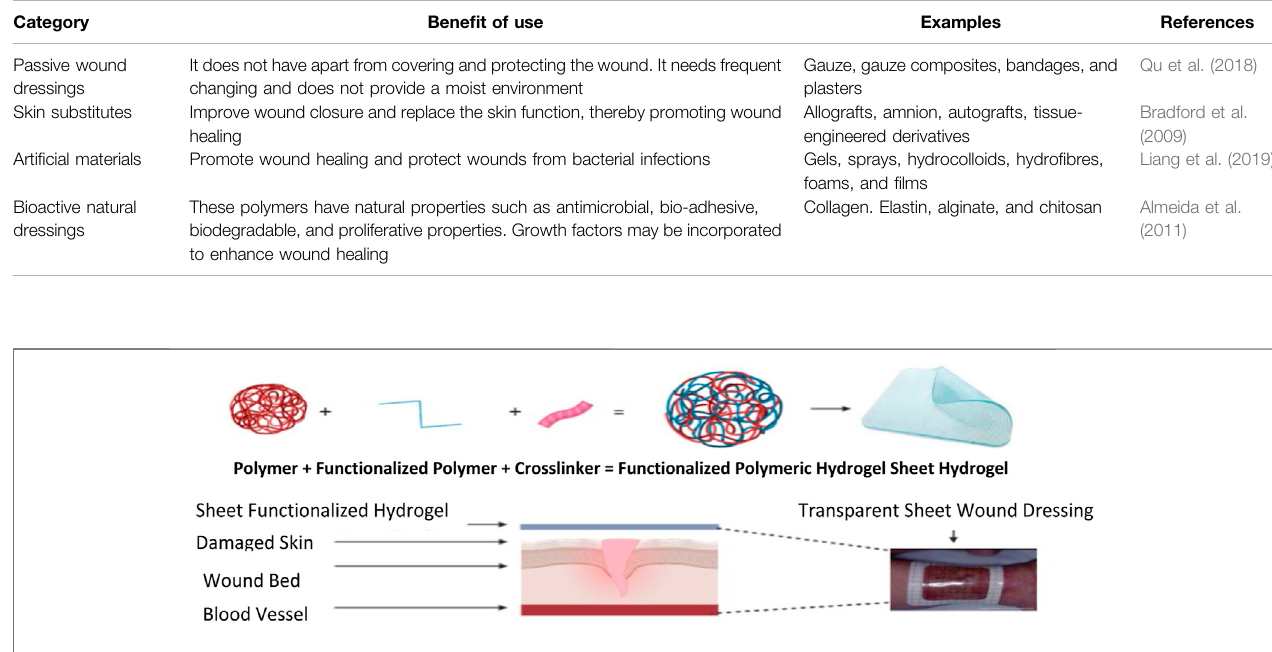
FIGURE 2 | Synthesis and application of sheet functionalized hydrogels for wound healing